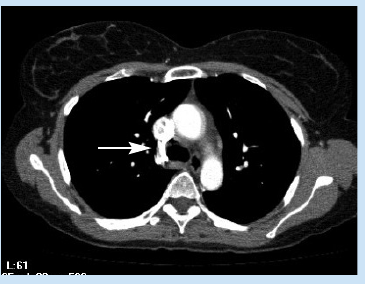
Fig. 1. Partly opacified azygous vein due to reflux from superior vena cava can be mistak- en for nodes if unopacified.